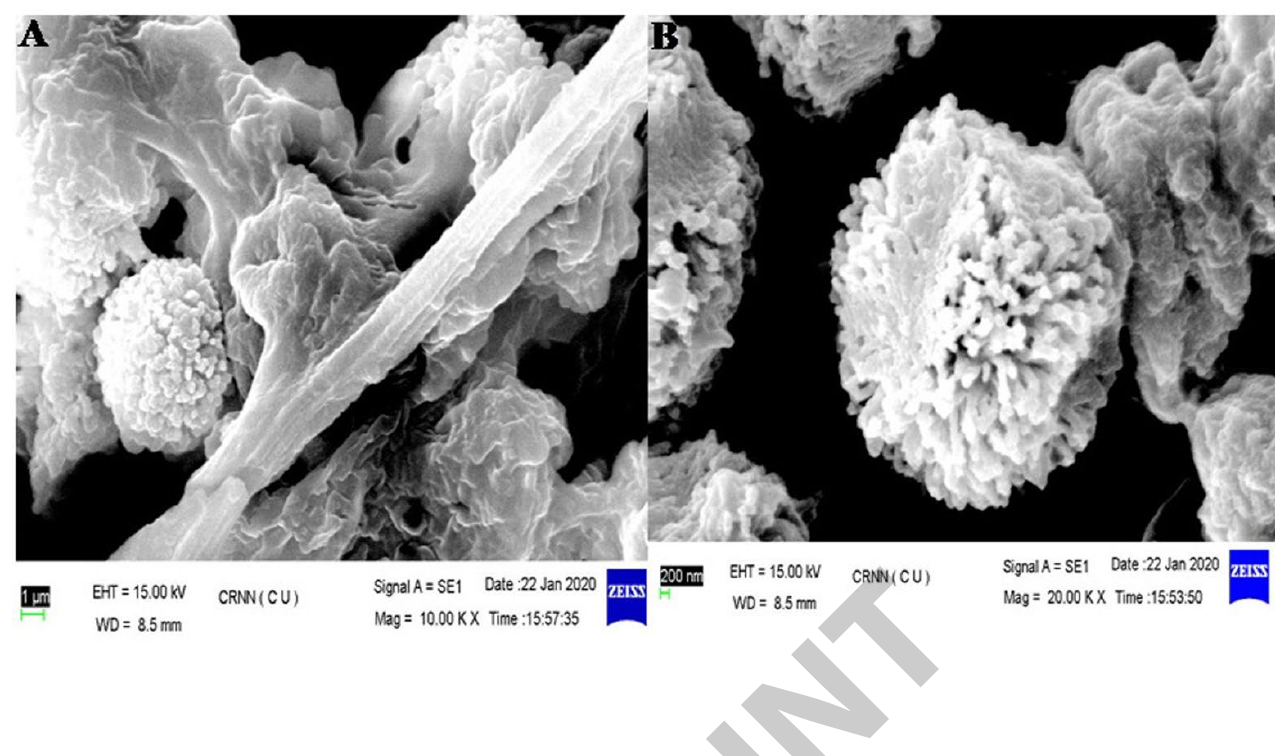
Figure 4 Scanning electron micrograph. A. Scanning electron micrograph of the hyphae structure (bar= 1 µm); B. Scanning electron micrograph of mature basidiospores displaying dense, rounded spine in groups (bar = 200